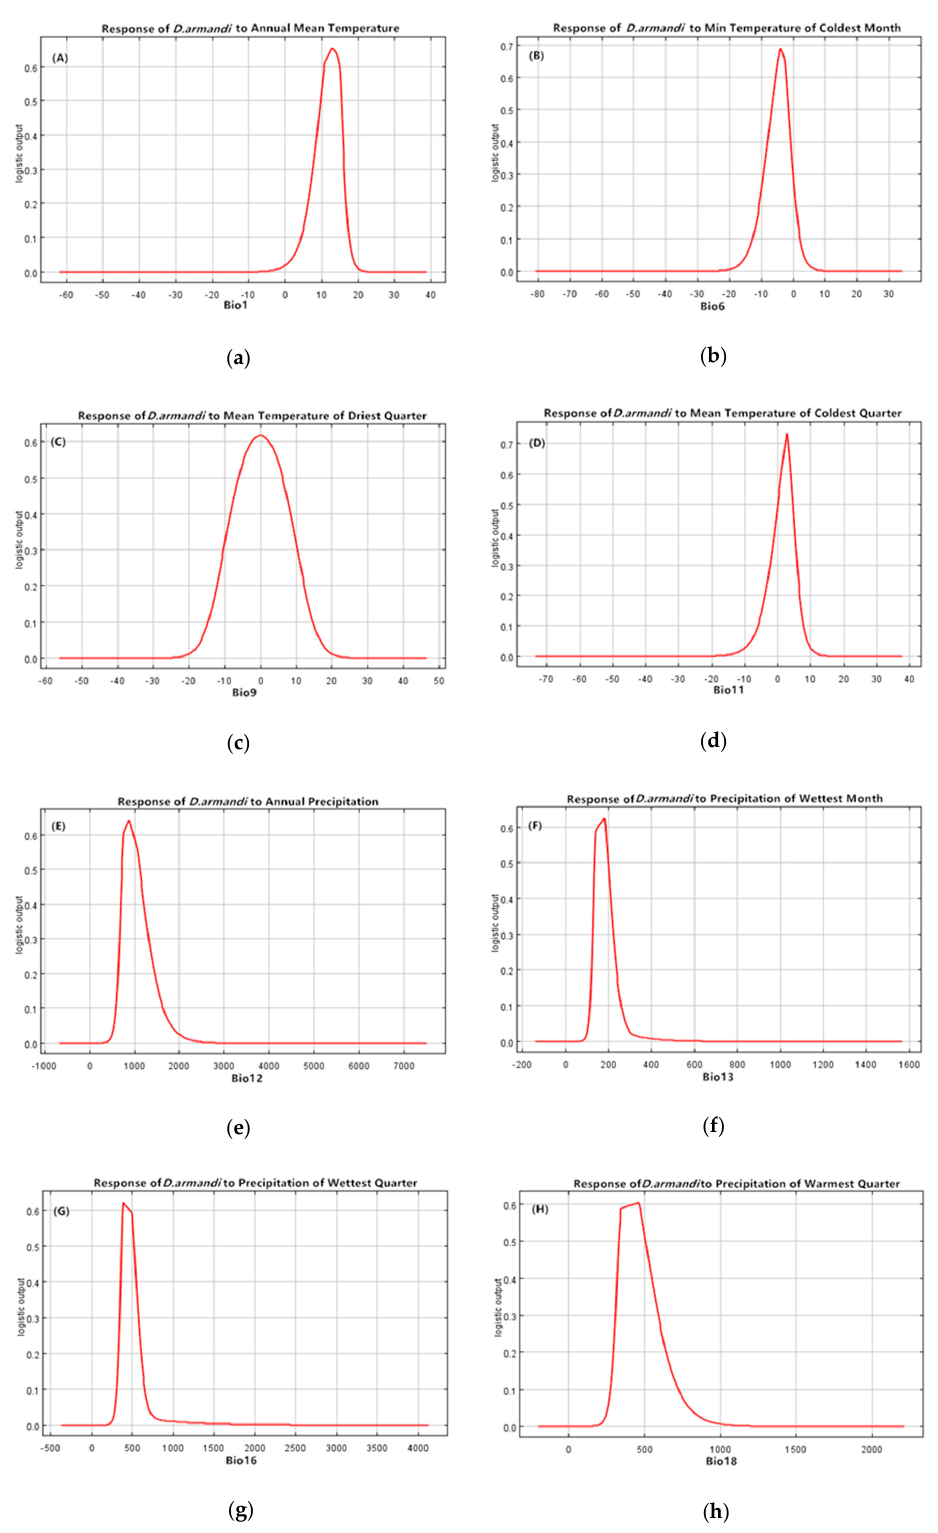
Figure 3. Response curves for the predictors of the MaxEnt Model.